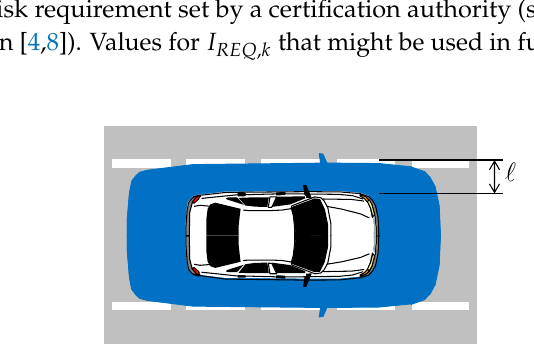
Figure 1. Defining Integrity Risk for Automotive Applications. The integrity risk is the probability of the car being outside the alert limit requirement box (blue shaded area) when it was estimated to be inside the box. When lateral deviation is of primary concern, then the alert limit is the distance (cid:96) between edge of car and edge of lane.